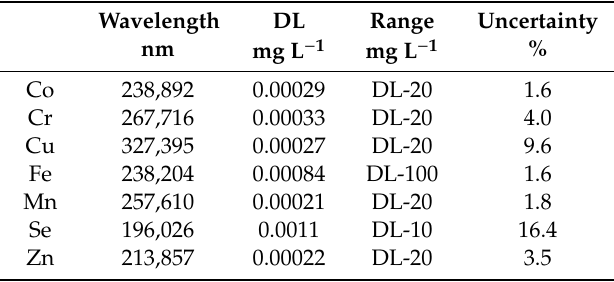
Table 4. Validation data for elements determination by inductively coupled plasma optical emission spectroscopy